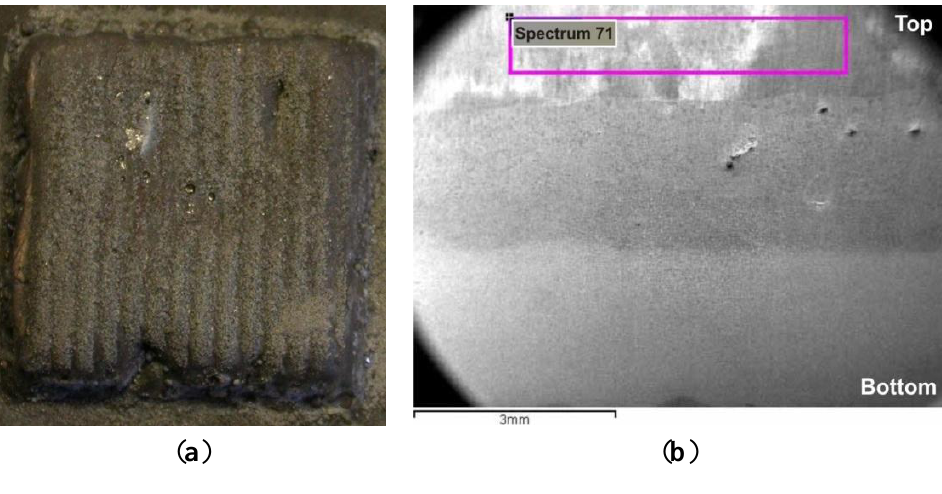
Figure 2. Top view ( a ) and the SEM cross section image ( b ) of the sample after